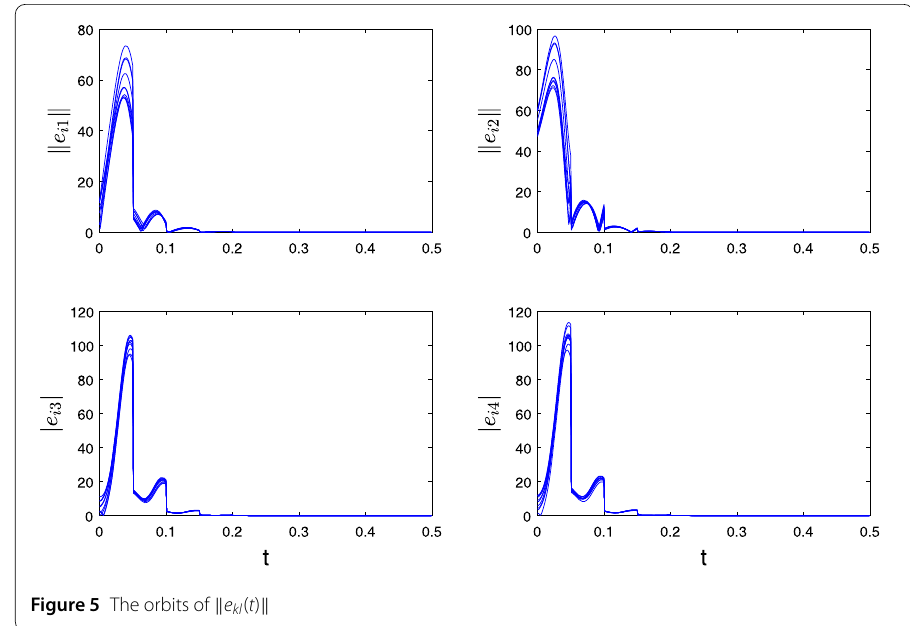
Figure 5 The orbits of (cid:9) e kl ( t )